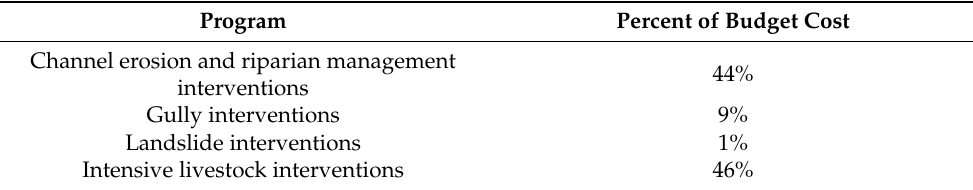
Table 5. Proportion of budget allocation to each subcatchment where ‘Source catchment’ repre- sents total contributing area, and ‘Excluding nested WTP’ represents the proportion of catchment only contributing to the referenced WTP. Table 6. Proportion of the scenario budget allocated to the different intervention